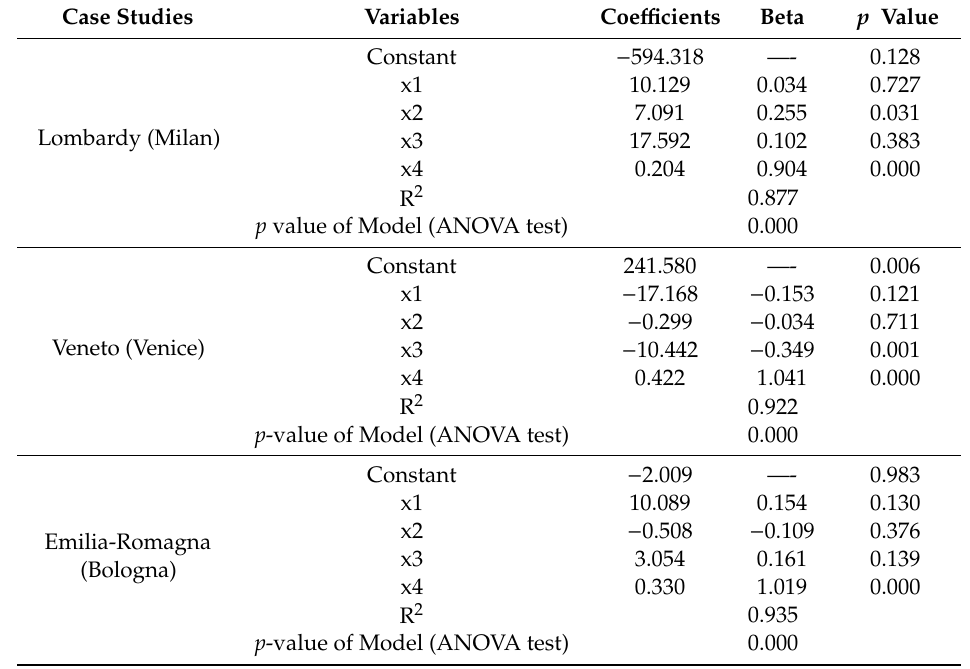
Table 7. The final coefficients, beta and significance of constant for independent variables.